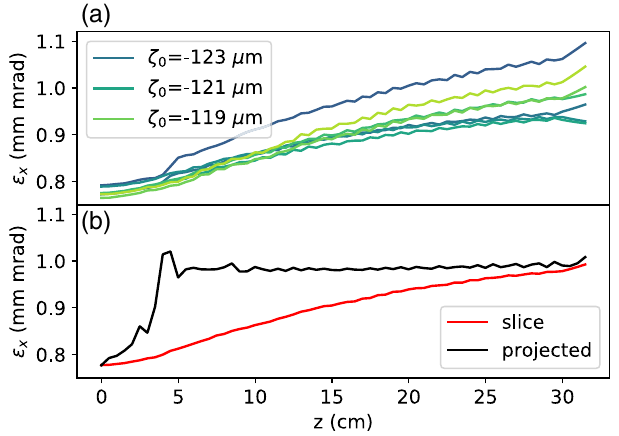
FIG. 2. Beam emittance along propagation when the laser pulse and the electron beam propagate along the capillary axis. (a) Emittance for several beam slices (from blue ζ 0 ¼ − 123 μ m to green ζ ¼ − 119 μ m). (b) Projected emittance 0 (black) and slice emittance (red). The simulation parameters are given in Table I. The emittance grows from 0.8 to 1.0 mm mrad, showing that the beam is not perfectly